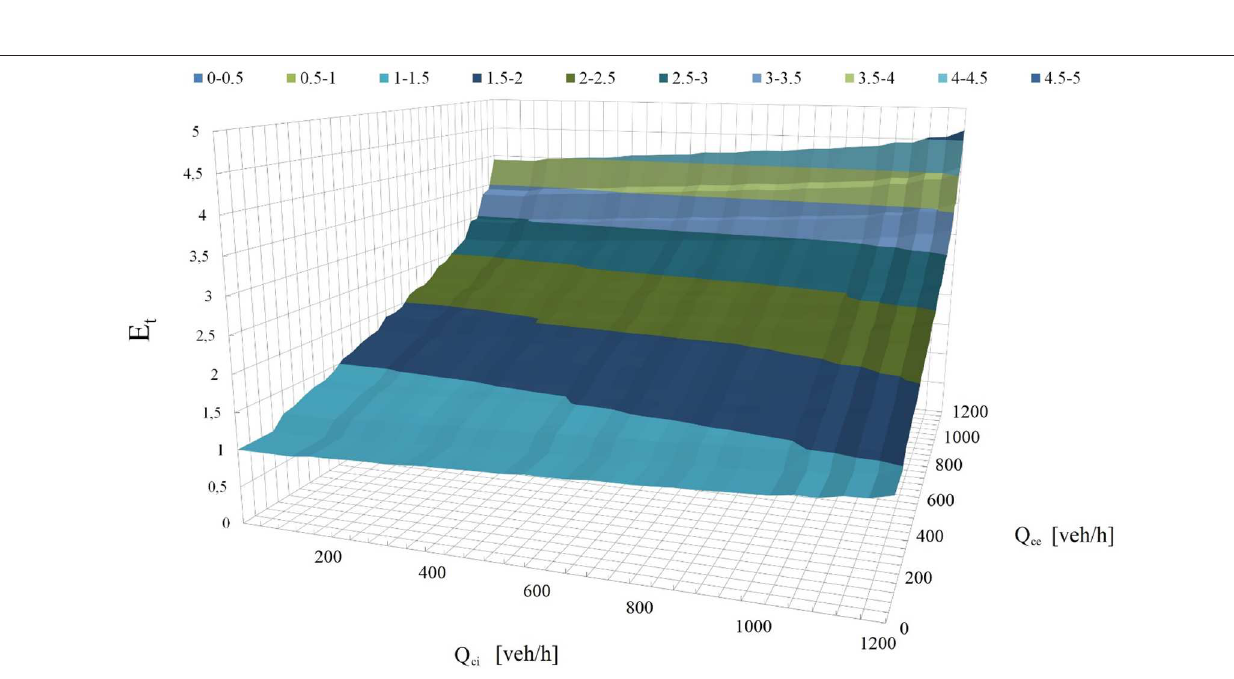
FIGURE 12 | PCE estimations for percentage of heavy vehicles of 20% for left lane at roundabout 1. E t , equivalent factor; Q ce , circulating flow on the outside lane [veh/h]; Q ci , circulating flow on the inside lane